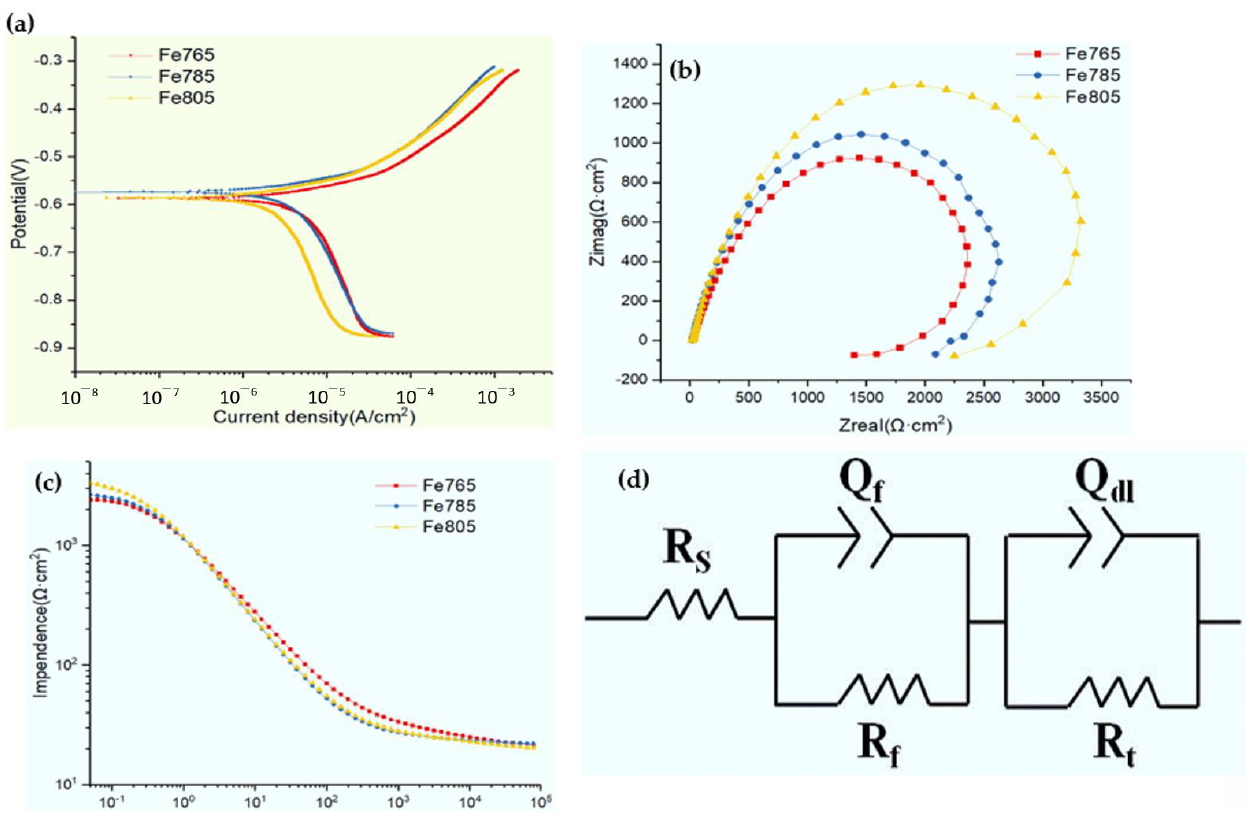
Figure 5. ( a ) Polarization curves, ( b ) Nyquist plots and ( c ) Bode plots of the different annealed conditions in Hank’s solution and ( d ) the equivalent circuit for impedance data fitting. Table 1. Polarization data of the different annealed conditions in Hank’s solution. Specimens No.